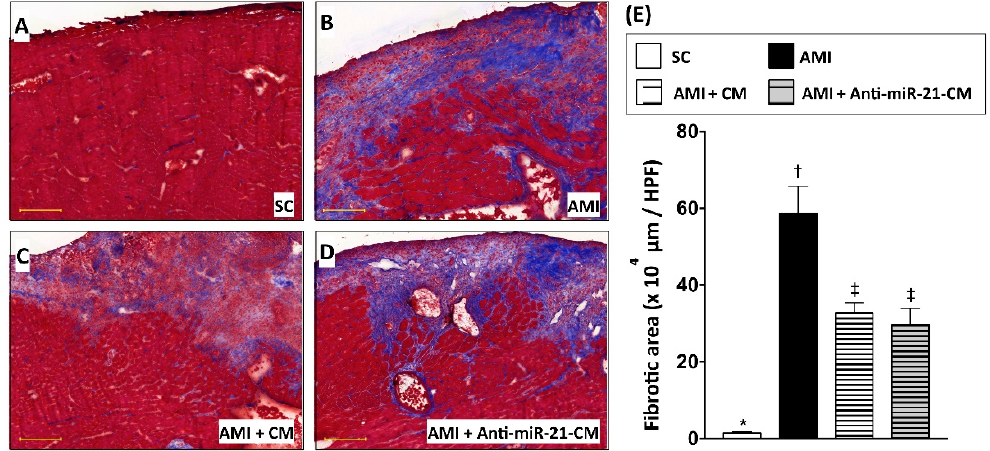
Figure 7. Conditioned medium derived from cardiomyocytes with oxygen–glucose deprivation decreased myocardial collagen deposition in rats with myocardial infarction. ( A ) Histopathological examination on sham control myocardial section with Masson’s trichrome (MTC) staining. ( B ) MTC staining for myocardial section from rats with AMI induction. ( C ) MTC staining for myocardial section from rats with AMI induction and injection of conditioned medium derived from OGD-treated cardiomyocytes. ( D ) MTC staining for myocardial section from rats with AMI induction and injection of conditioned medium derived from OGD-treated cardiomyocytes with anti-miR-21 pre-transfection. ( E ) Calculation of collagen disposition area in myocardium. SC, sham control. AMI, acute myocardial infarction. CM, conditioned medium derived from OGD-treated cardiomyocytes. Anti-miR-21-CM, conditioned medium derived from cardiomyocytes pre-transfected with anti-miR-21. Groups with di ff erent symbols (*, † , ‡ ), p < 0.05. n = 8 for each group. Scale bar in left lower corner indicates 200 µ